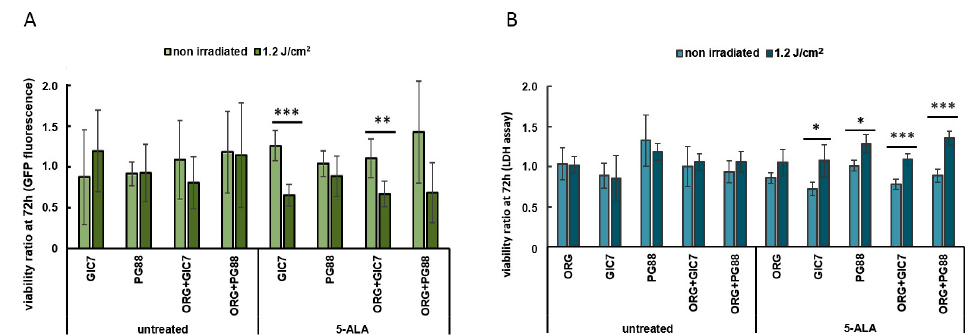
Figure 8. Cell viability after PDT of tumorspheres alone and co-cultured with brain organoids. ( A ) GICs viability after 72h post-irradiation using the GFP fluorescence ratio between each endpoint and time 0. ( B ) Global cell viability considering the ratio between the LDH release at 72 h post- irradiation and at time 0. Results are the mean ± SE of two independent experiments ( n = 2) performed using six replicates. * p <0.05, ** p <0.01, *** p <0.005.